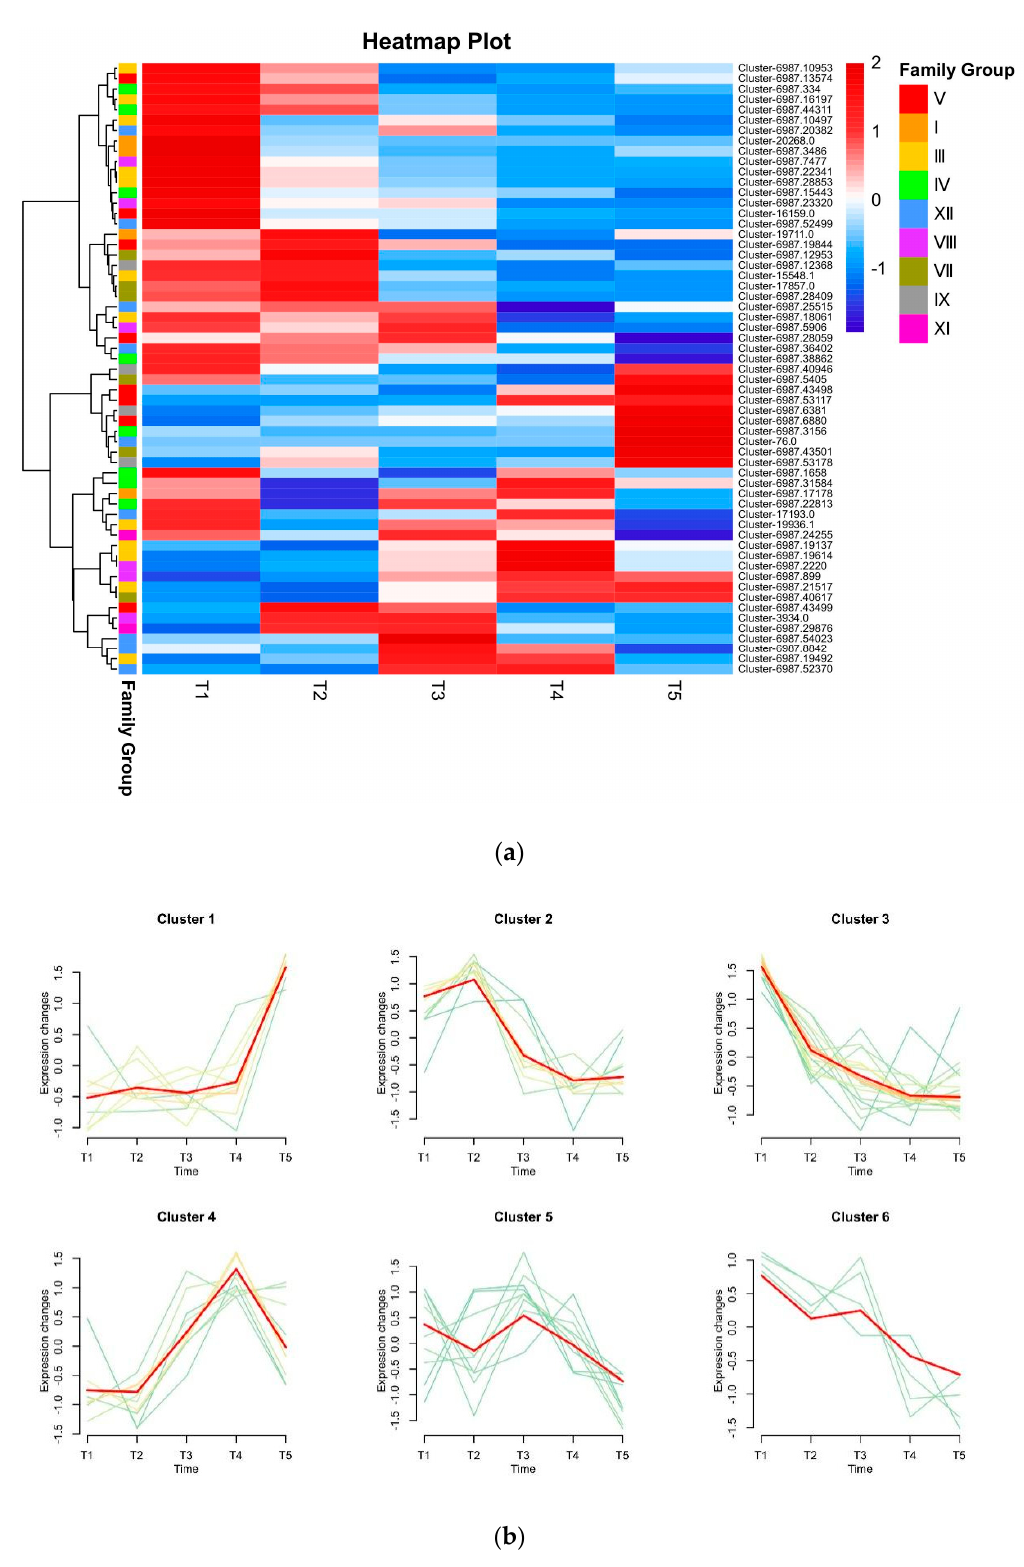
Figure 5. Gene expression analysis of bHLH genes in D. kaki fruit at fi ve stages. ( a ) Heat map clustering of DkbHLH gene expression levels at fi ve developmental stages; heatmaps depict the normalised gene expression values, which represent the mean value of three biological replicates. ( b ) Clustering analysis of DkbHLH genes.